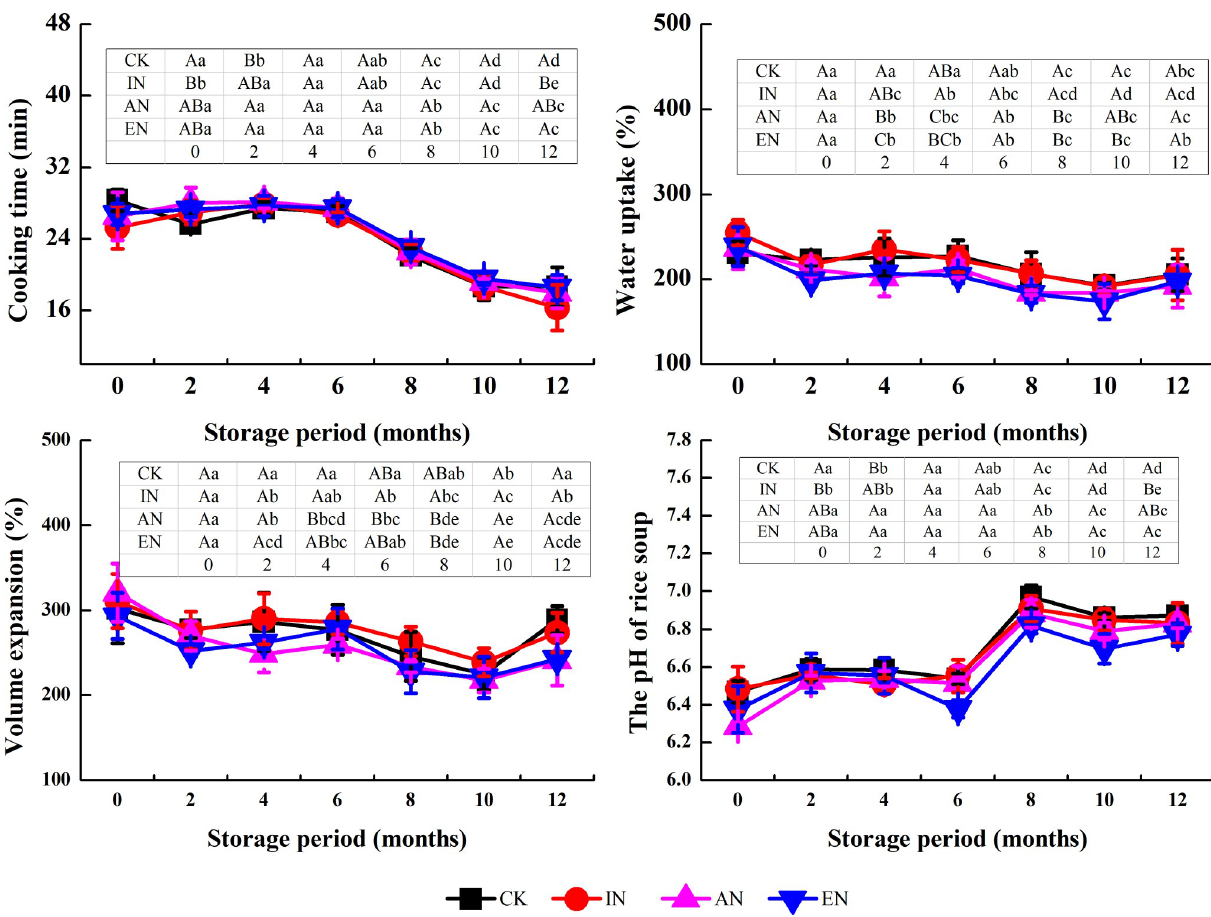
Fig 5. Changes in the cooking quality of rice during storage, after the different nitrogen application rates. CK, control group (0 kg N/ha); IN, insufficient nitrogen (160 kg N/ha); AN, adequate nitrogen (260 kg N/ha); EN, excessive nitrogen (420 kg N/ha). For each parameter, the mean ± standard deviation (n = 3) followed by different lowercase letters in the same rows differ significantly as a function of storage time (Duncan’s test; p < 0.05). Different uppercase letters in the column denote significant differences as a function of different nitrogen application rates (p < 0.05).